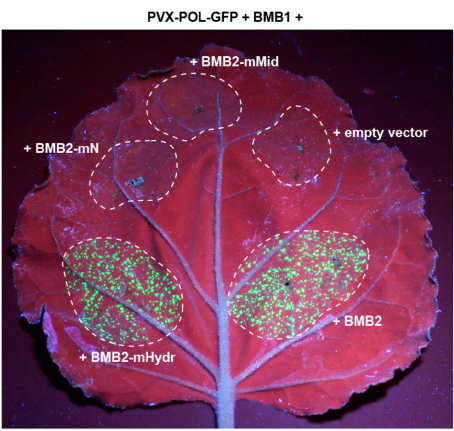
Figure 6. Analysis of functional competence of BMB2 mutants. Complementation of cell-to-cell movement of PVX-POL-GFP by combinations of BMB1 with BMB2 (positive control), BMB2-mN, BMB2-mHydr, BMB2-mMid and empty vector (negative control) is shown. The leaf was imaged under UV light at 5 d.p.a. Dashed lines encircle infiltrated